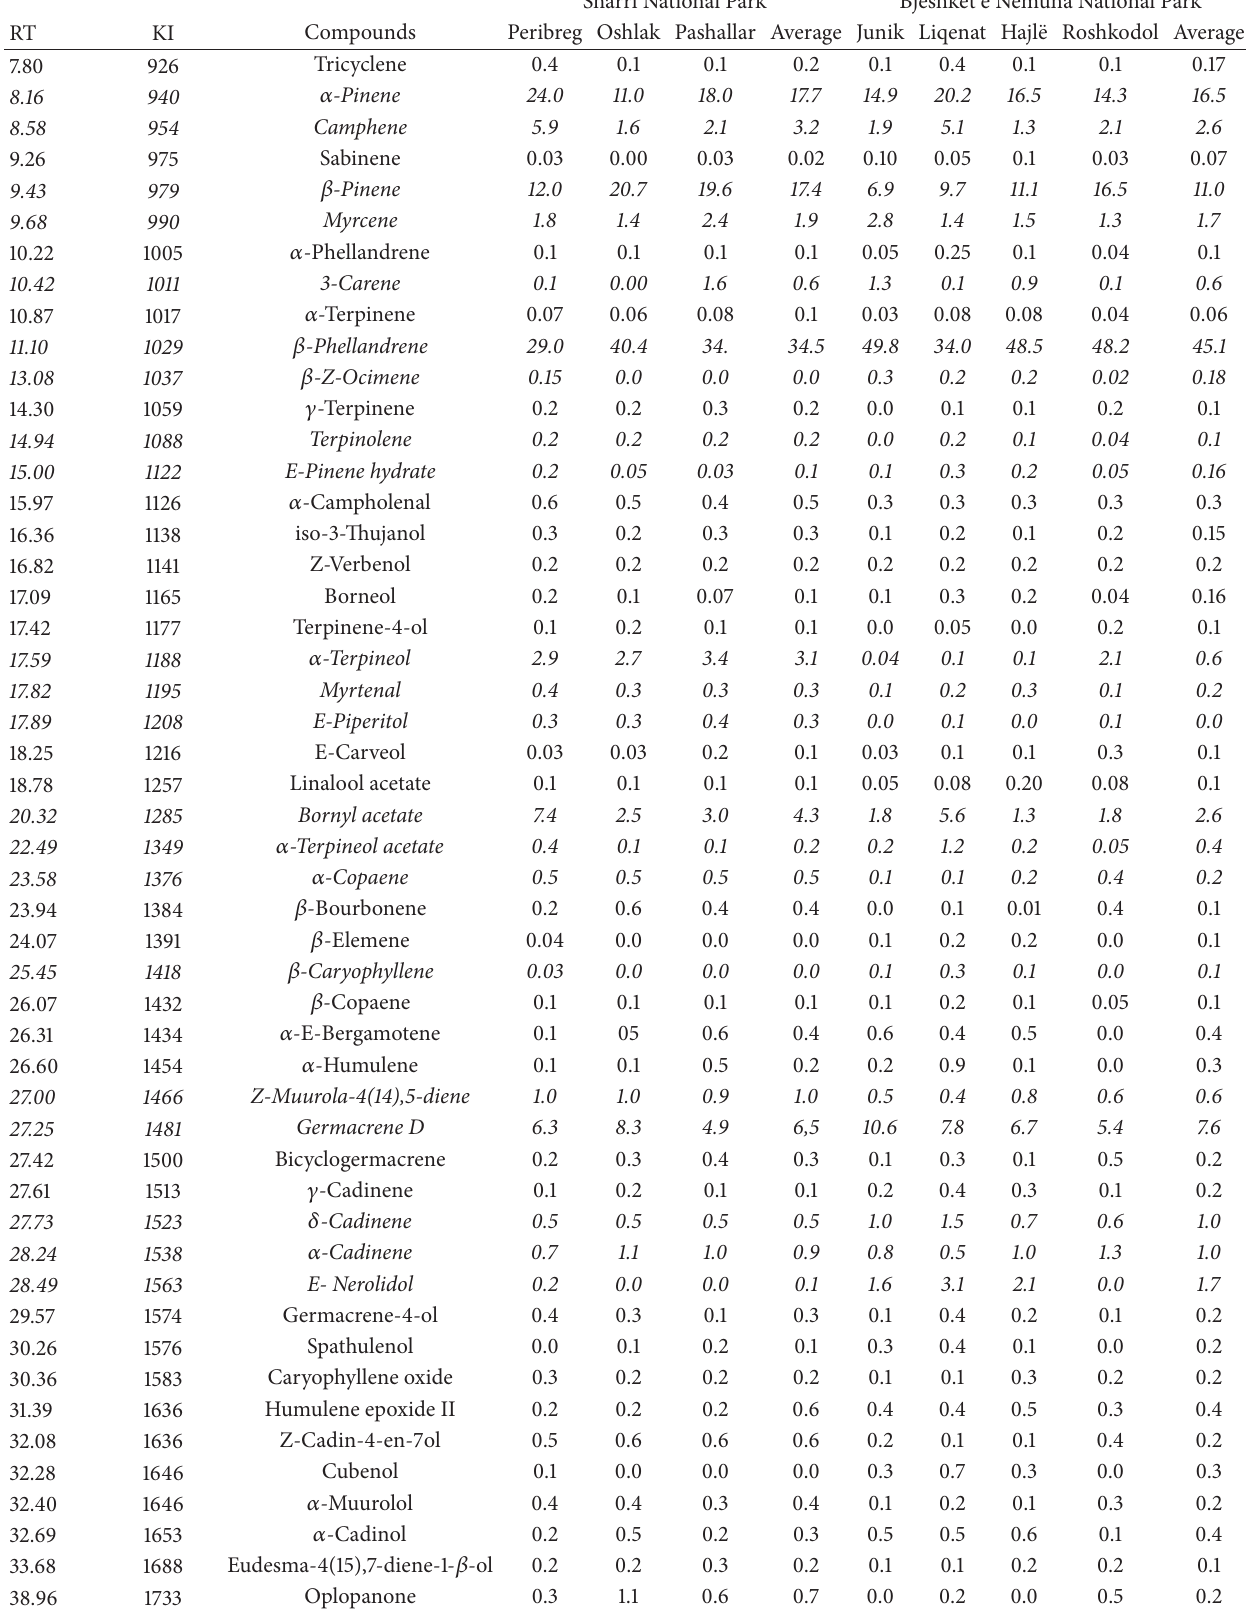
Table 3: Composition (%) of the twigs oils of Pinus peuce from different